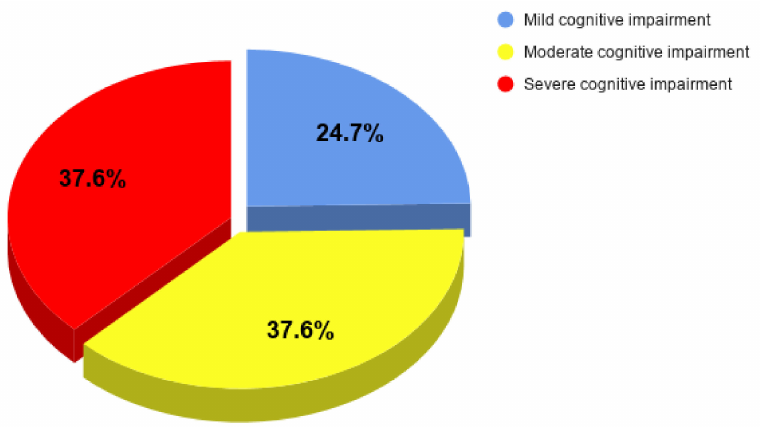
Figure 1. Dementia severity in Alzheimer’s charges before the Covid-19 as assessed by